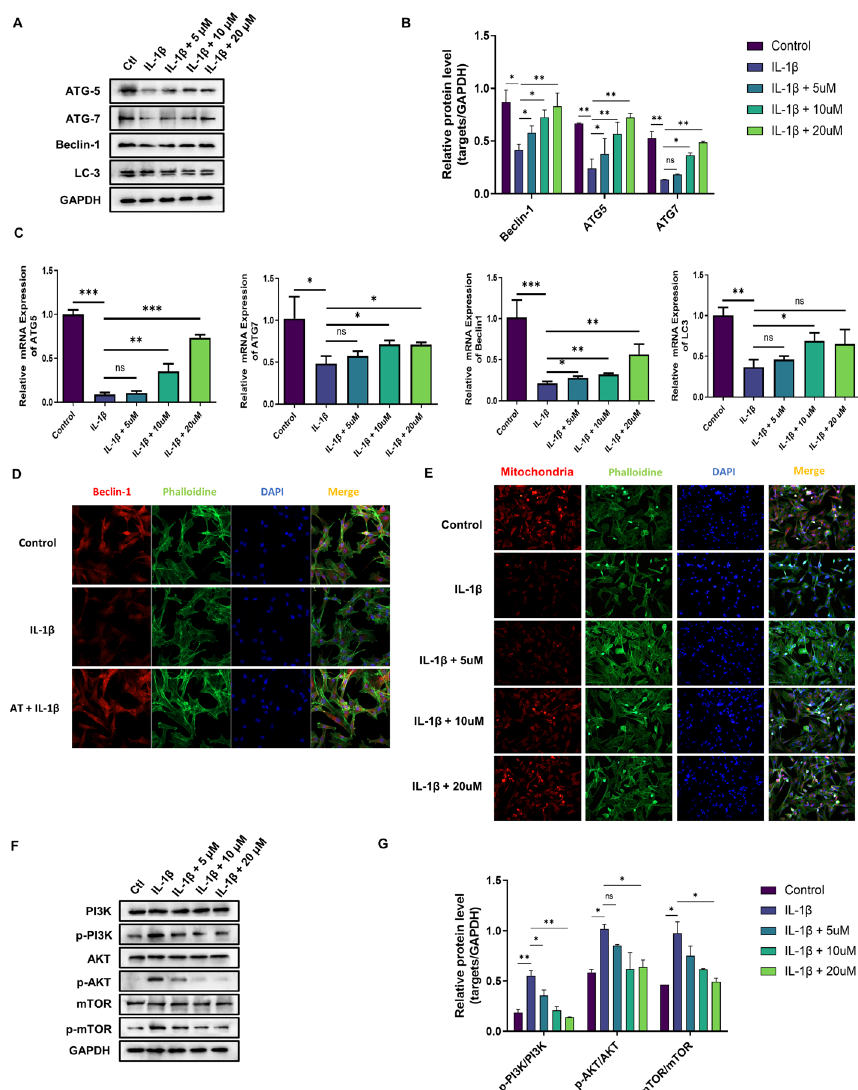
Fig. 4 Anti-arthritic effect of AT on IL-1β induced chondrocytes via activating mitochondrial autophagy through inhibiting PI3K/AKT/mTOR. A Western blot was used to analyze the proteins ATG-5, ATG-7, beclin-1, and LC-3, which are autophagy-related proteins. B Protein level of ATG-5, ATG-7, beclin-1, and LC-3 normalized to GAPDH using ImageJ software. C Real-time RT-PCR was performed to determine the gene expression of ATG-5, ATG-7, beclin-1, and LC-3. D Immunofluorescence staining for beclin-1, phalloidin was stained for cellular actin, and DAPI was stained for nuclear. Control: without IL-1β; IL-1β group: with 10 ng/ mL; IL-1β AT group: with 10 ng/mL IL-1β and 20 μM AT. E Immunofluorescence staining for mitochondria; + phalloidin was stained for cellular actin, and DAPI was stained for nuclear. Control: without IL-1β; IL-1β group: with 10 ng/mL; IL-1β AT group: with 10 ng/mL IL-1β and 5, 10 and 20 μM AT. F Western blot was used to + analyze the proteins of the PI3K/AKT/mTOR signaling pathway, including PI3K, p-PI3K, AKT, p-AKT, mTOR, and p-mTOR. G Protein level of PI3K, p-PI3K, AKT, p-AKT, mTOR, and p-mTOR normalized using ImageJ software. All experiments were performed in triplicate. Data represent the mean SD ( n 3), * P < 0.05, ** P < 0.01 and ± = *** P < 0.001 versus the IL-1β